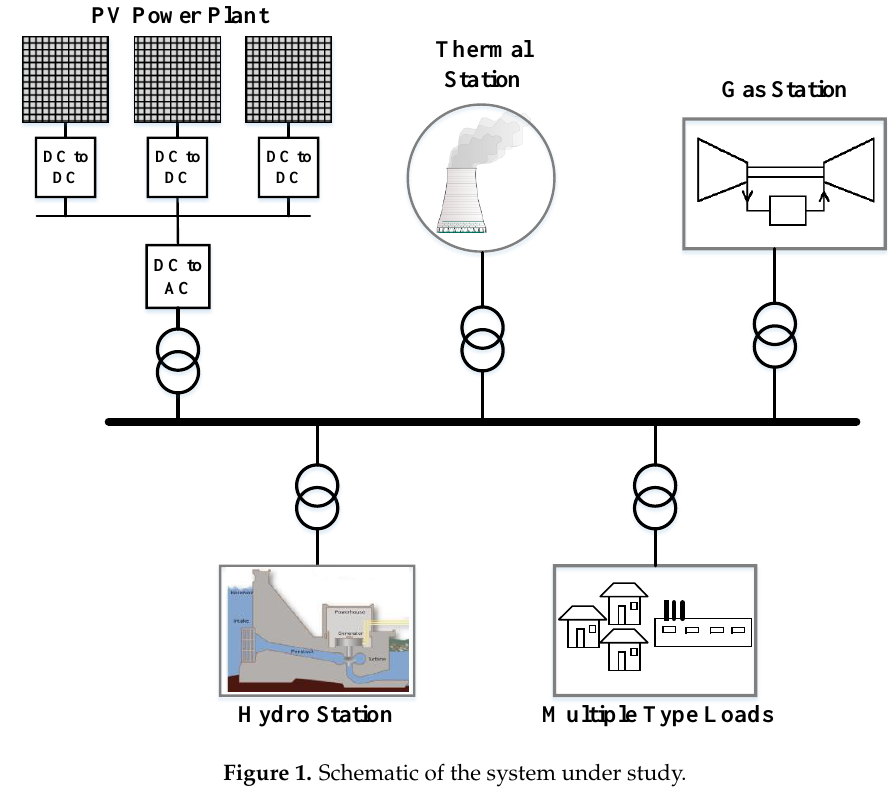
Figure 1. Schematic of the system under study.